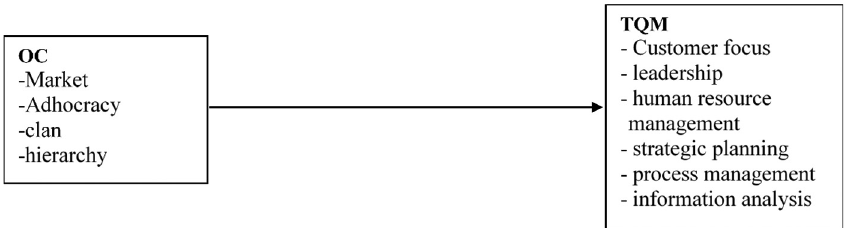
Figure 1. Research